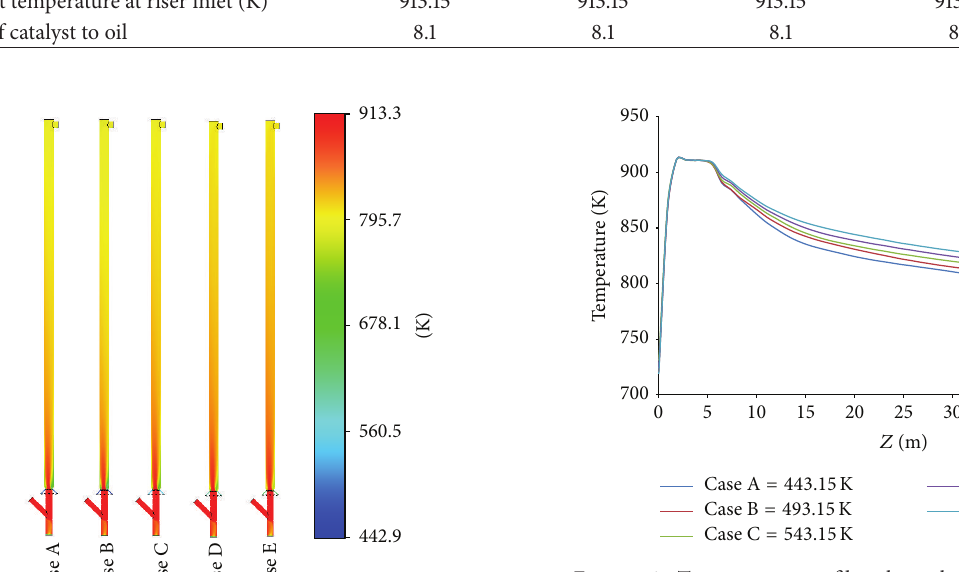
Figure 9: Temperature profiles through riser with variation in feedstock temperature.